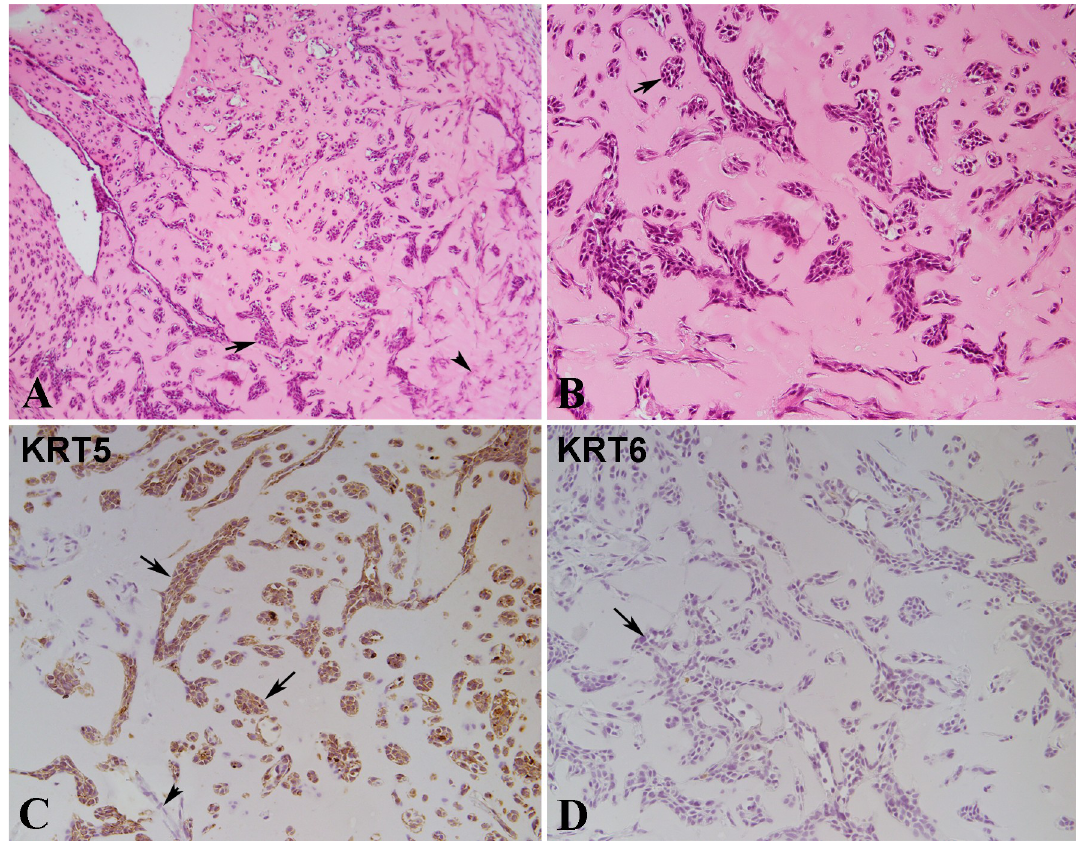
Fig 8. Histology and Immuno-histochemical staining of nodules formed by UROtsa cells injected with matrigel in immune compromised mice. (A). Histology of UROtsa nodule at lower magnification (100X). Epithelial nests in different size and shape and single cells seen in the matrigel (arrows). Spindle stroma cells are present in the right part of the image (arrowhead), mainly in the right part of the image. (B). Histology of UROtsa matrigel nodule at higher magnification (200X). Most of the epithelial nests are irregular in shape with branches or angular formation. A few of epithelial nests are oval or round in shape, similar to the von Brunn’s nests (arrow) in human bladder. Some smaller nests or clusters are composed of only a few epithelial cells. (C). Immunostaining for KRT5. The epithelial nests of various size and some single cells are strongly positive for KRT5 (arrow). The spindle stroma cells are negative for KRT5 (arrowhead). (D). Immunostaining for KRT6. The epithelial nests and single epithelial cells are negative for KRT6 (arrows). All images are at a magnification of 200X unless